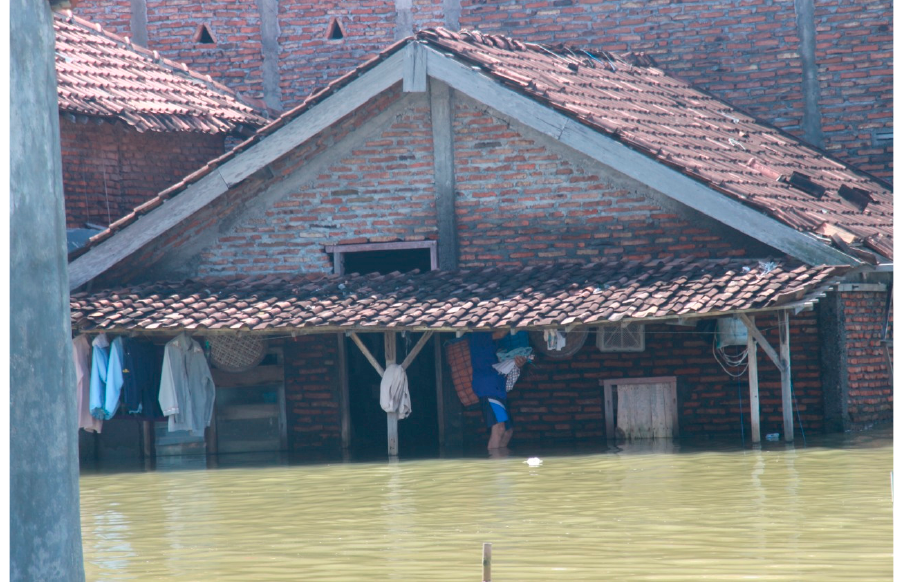
Figure 7. Landowner who is unable to perform landfilling and unable to move to another area. Consequently, they have to adapt with the sea water that inundated the house. Source: field data collection.